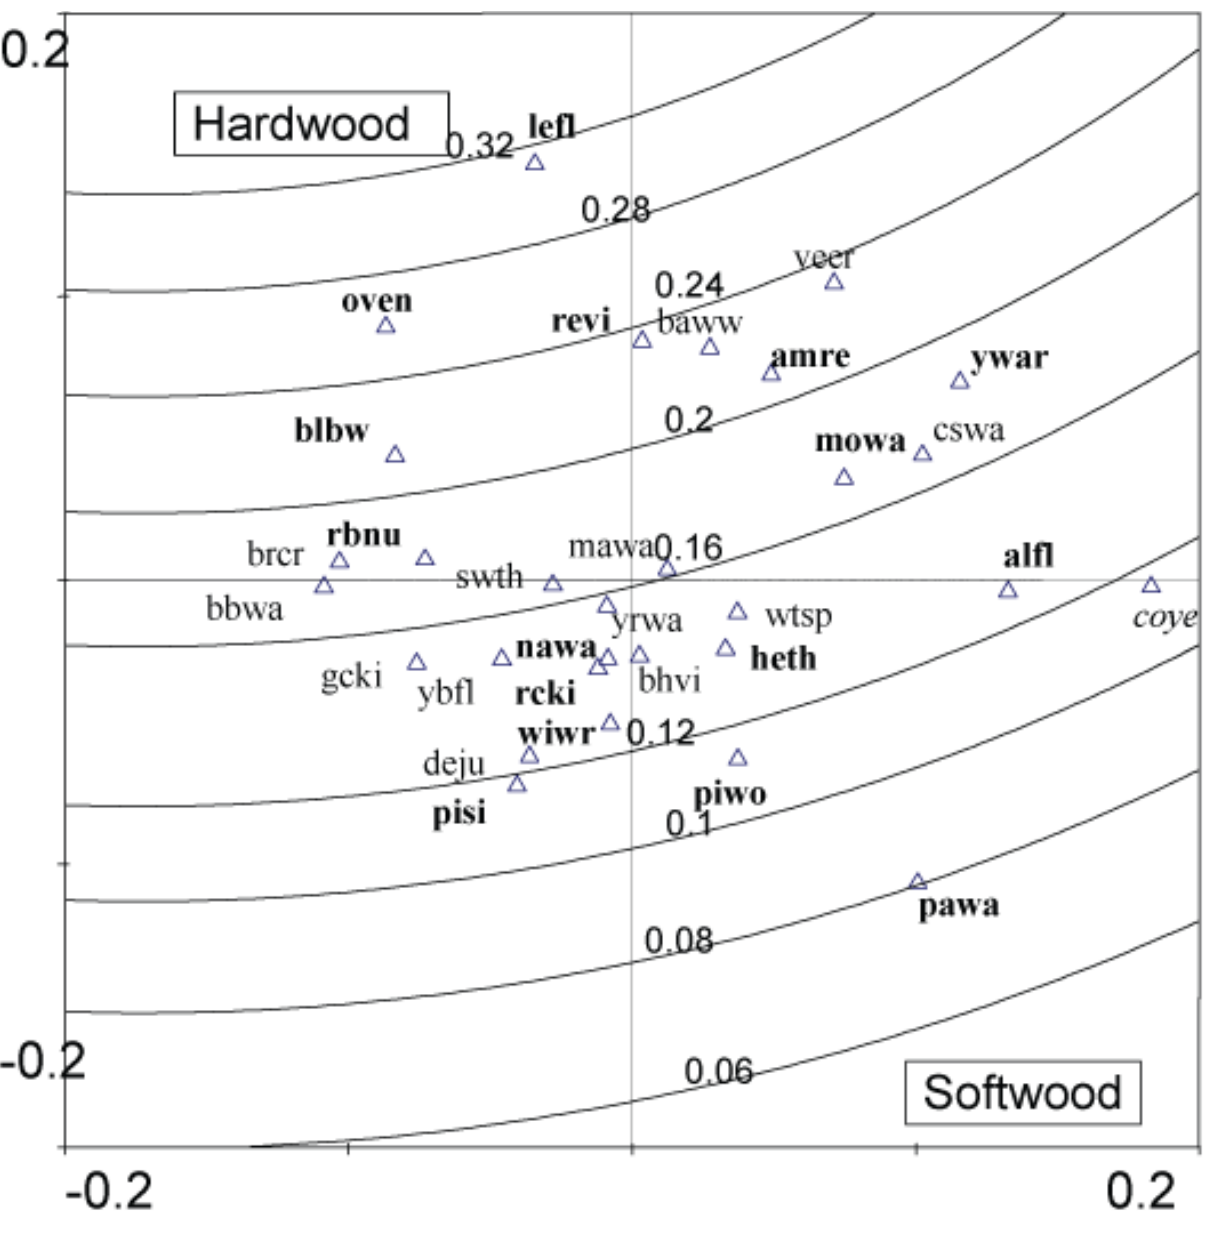
Fig. 5. Species ordination (CCA), with overlay of isopleths (GLM) for percent hardwood volume (HARDWOOD). Species with a significant effect (ANOVA p < 0.05) are highlighted in bold. Isopleths delineate species predicted to occur in areas of low to high proportions of hardwood